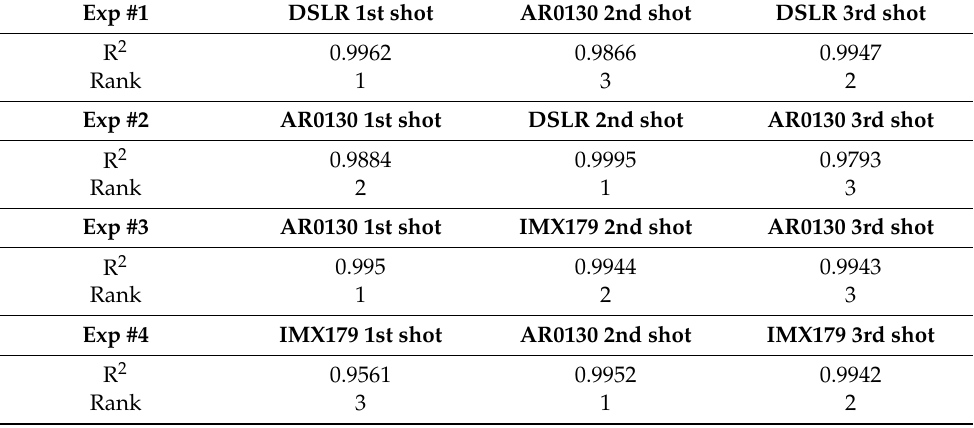
Table 4. Results by